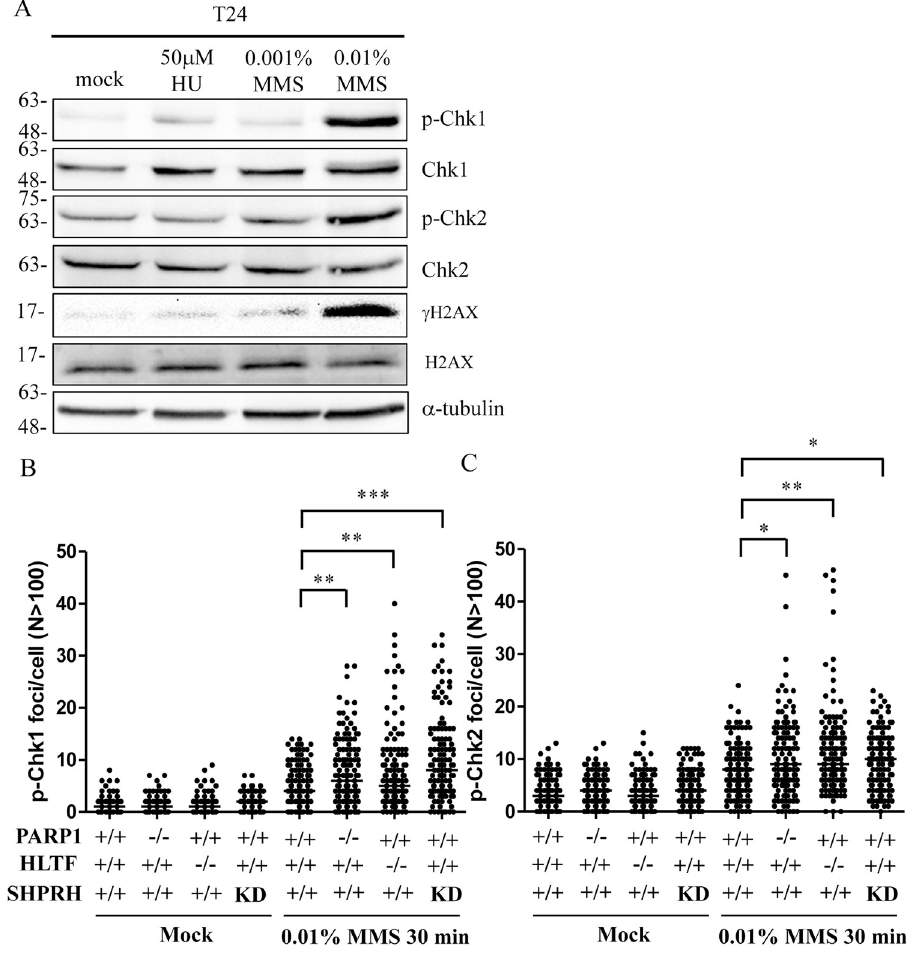
Fig 6. Higher levels of CHK1 and CHK2 phosphorylation are induced by 0.01% MMS than 50 μ M HU or 0.001% MMS. (A) Cells were treated with 50 μ M HU, 0.001% MMS, or 0.01% MMS for 1 hour. Cells were fixed and immunostained with antibodies as indicated. (B)(C) PARP1-, HLTF, and SHPRH-deficient cells showed higher levels of phospho-CHK1 and phospho-CHK2 than control cells. (Raw p-CHK1/pCHK2 data in S6